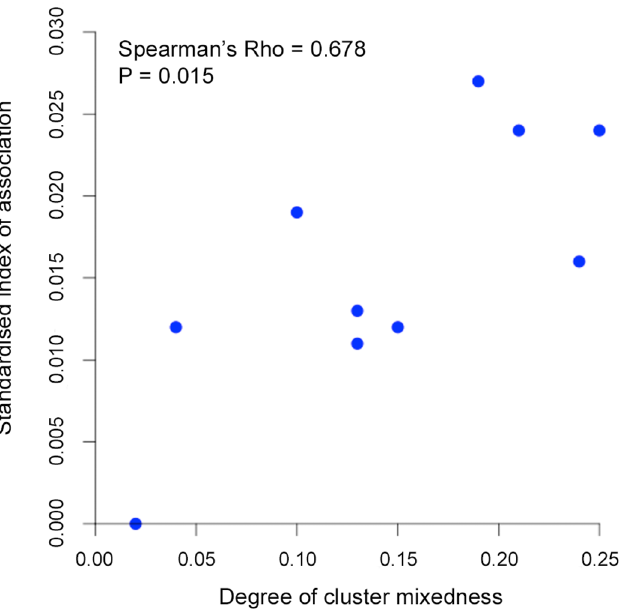
Fig 5. Correlation between degree of cluster admixture and multi-locus linkage disequilibrium (standardised index of association). The degree of P . knowlesi cluster admixture was estimated as the local cluster mixedness ( p1 * p2 ) based on the proportions of infections designated as Cluster 1 ( p1 ) and Cluster 2 ( p2 ) at each of 10 sampling sites for human infections across Malaysia (Spearman ’ s Rho = 0.678, P = 0.015). S5 Table gives details of each of these values for each